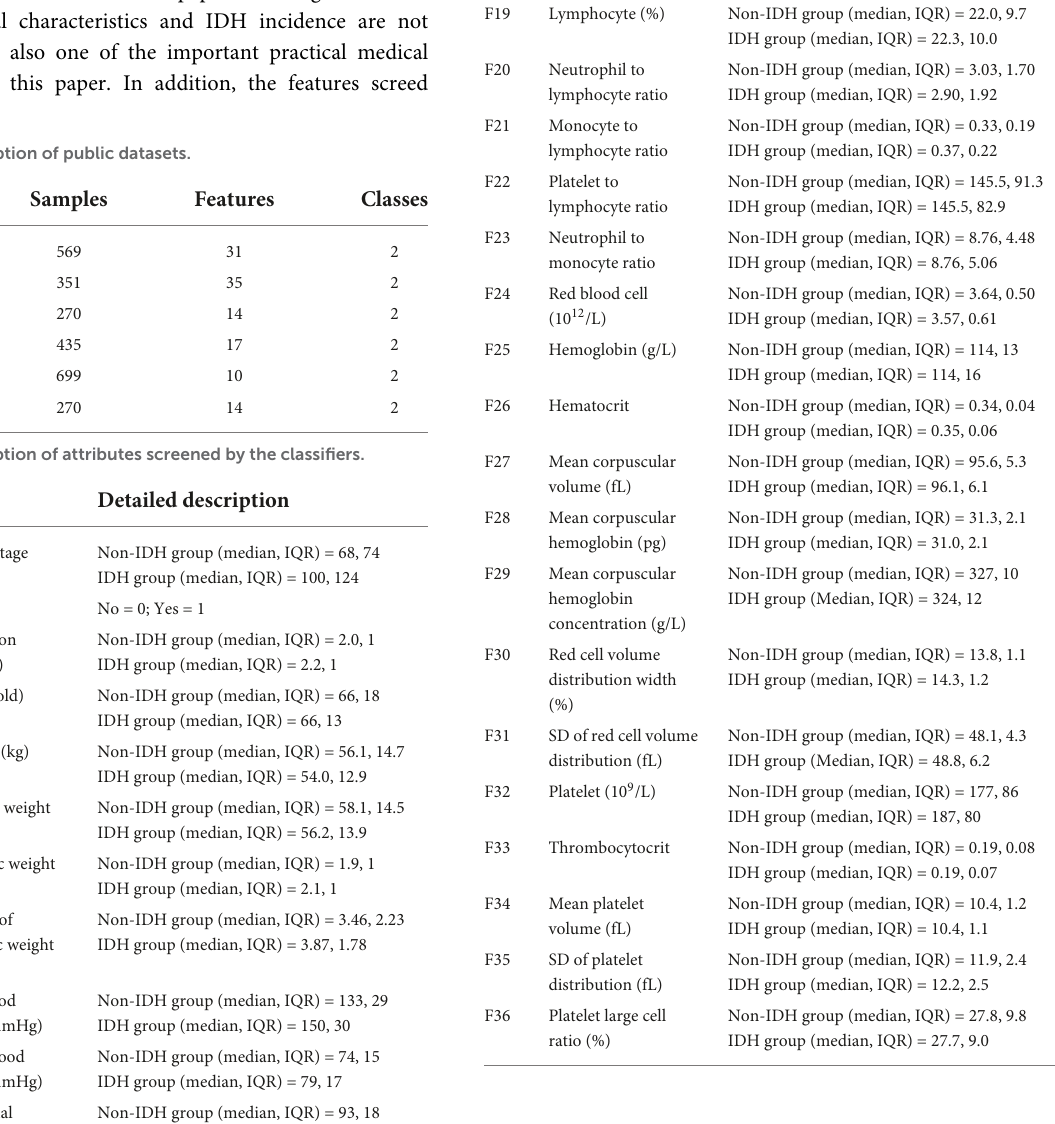
TABLE 16 Description of classification